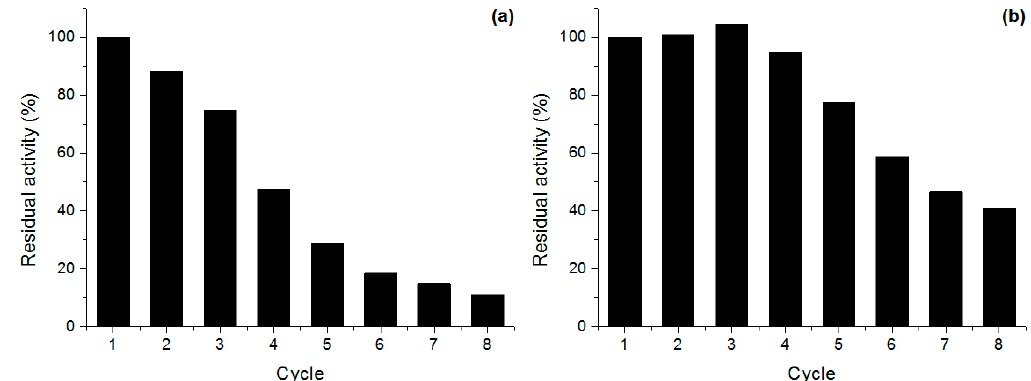
Figure 3. Reuse of ( a ) octyl and ( b ) phenyl derivatives of Penicillium sp. (CBMAI 1583) lipase on p NPP hydrolysis. Reactions were carried out in sodium phosphate buffer pH 7.0 at room temperature, as described in Section 3.9.